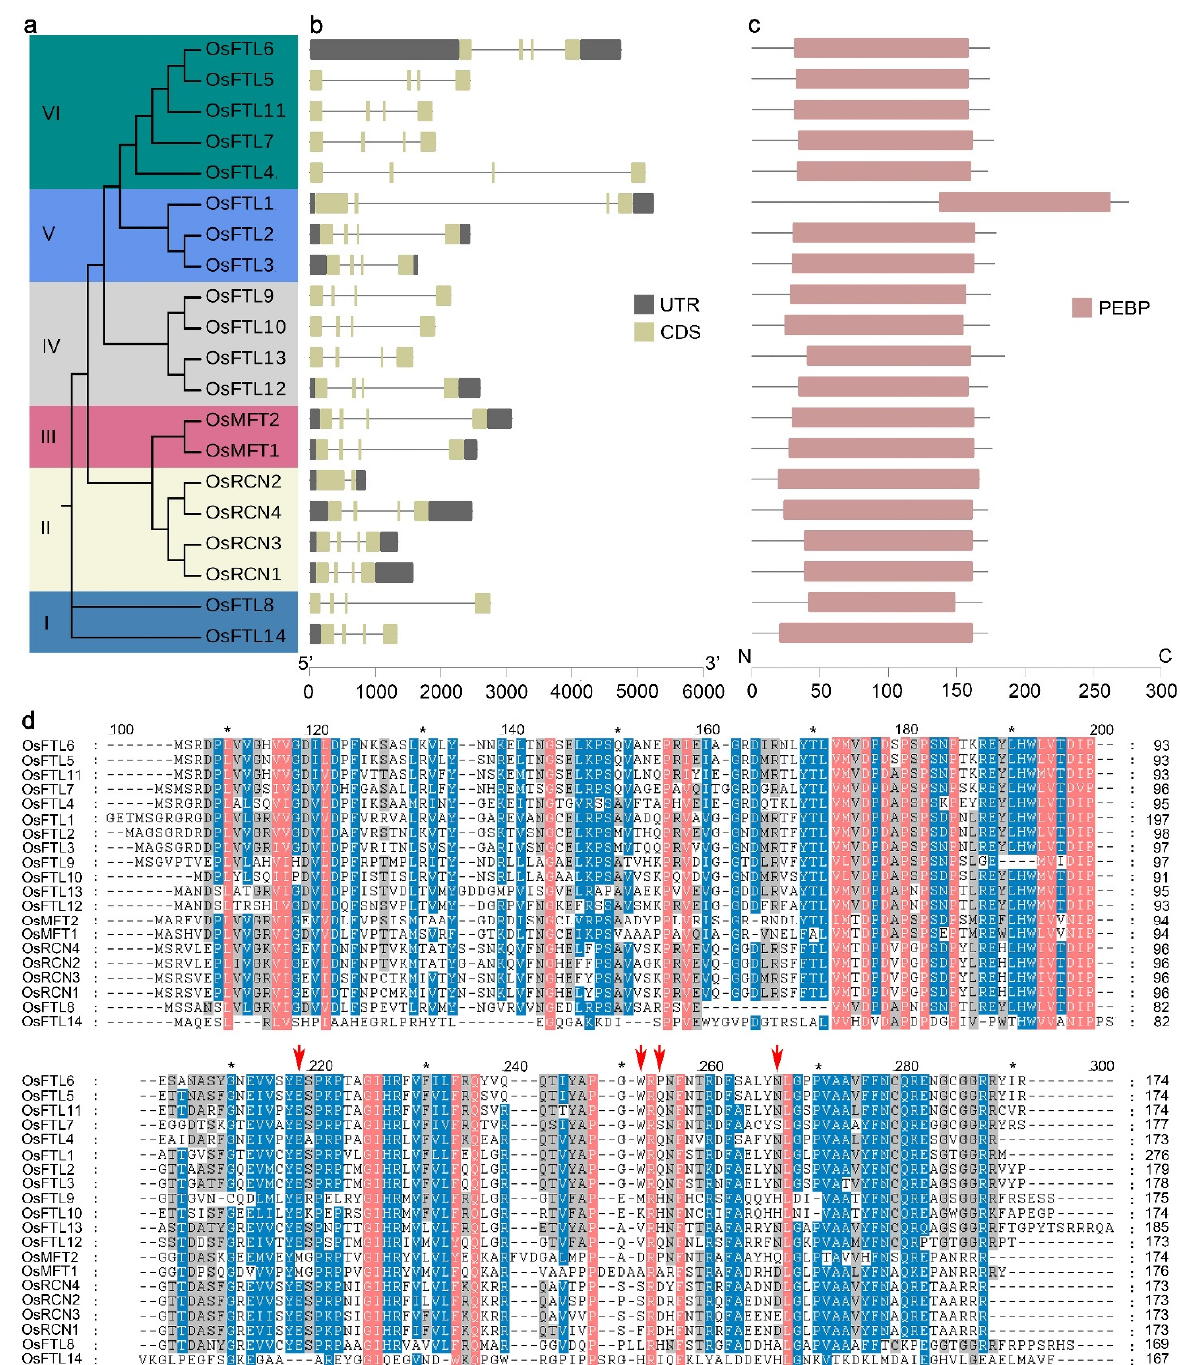
Figure 3. Phylogenetic tree and gene structure of OsPEBP in rice. ( a ) The phylogenetic tree of OsPEBPs. Different colors represent the subgroup of OsPEBPs. ( b ) OsPEBP gene structure. Black and yellow rectangles, and black lines indicate UTR, exon, and introns, respectively. UTR represents untranslated region. ( c ) Domains in OsPEBP protein. Pink rectangles represent PEBP domains. The rulers on the bottom of ( b , c ) are the scale bar measuring the length of PEBP genes and proteins. ( d ) Alignment of OsPEBP proteins. The red arrows indicate the potential key amino acid residuals of OsPEBPs.